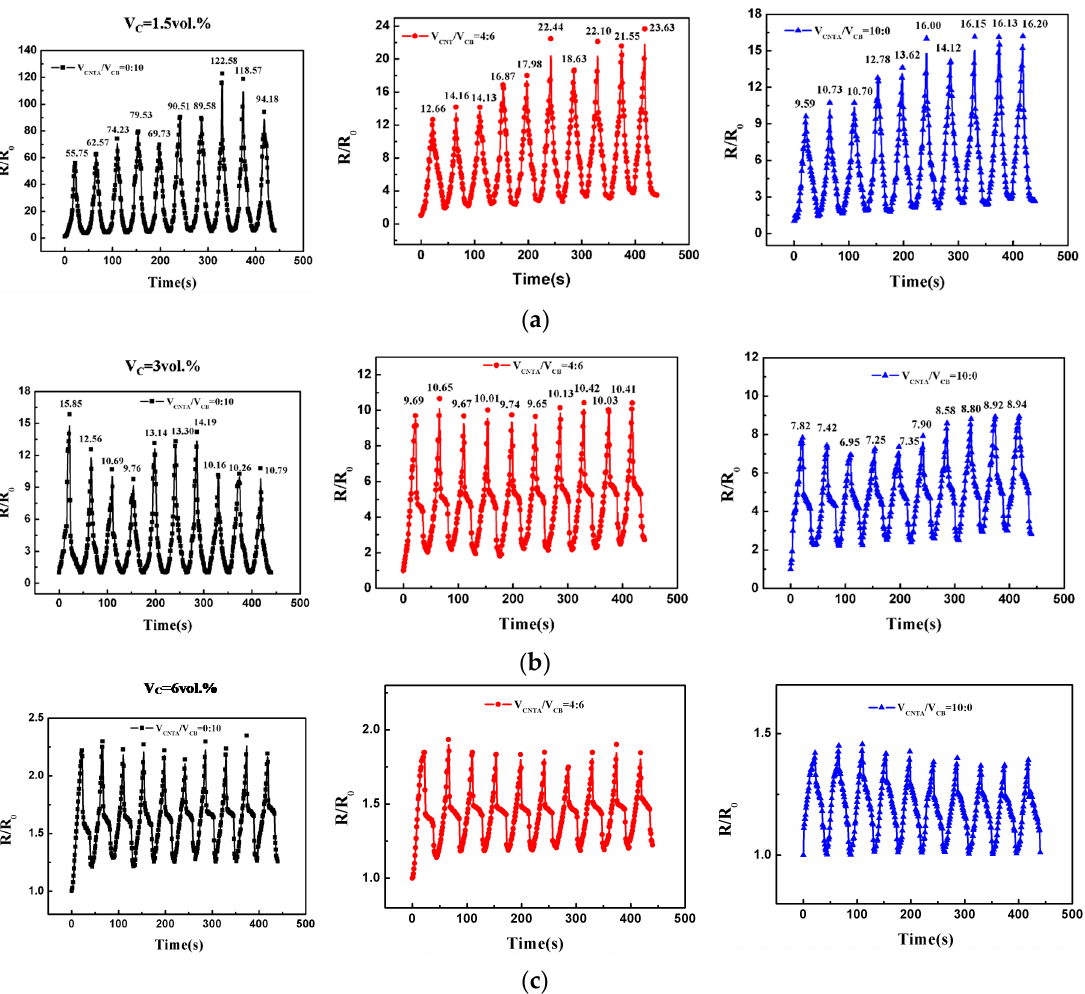
Figure 4. Relative R-time relationship for composites of 1.5 vol % ( a ), 3 vol % ( b ), and 6 vol % ( c ) fillers.